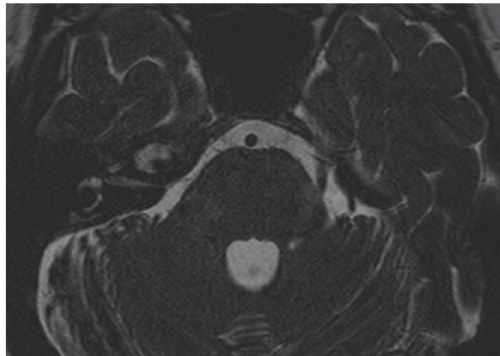
Figure 2: Axial T2-weighted image showes a hyperintense lesion in the right petrous apex.